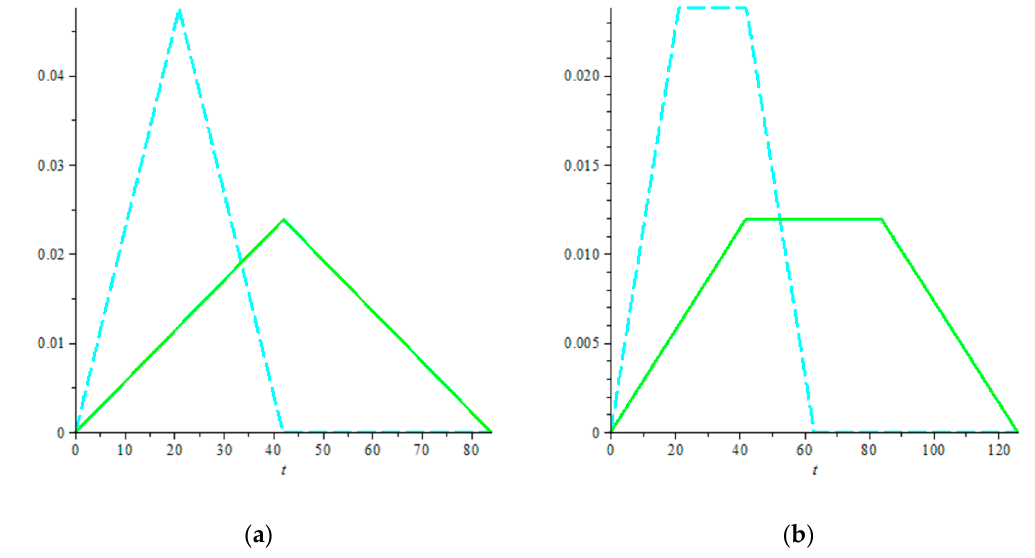
Figure 9. PDFs for the travel times of a semi-random trip (cyan dash) and an SC cycle (green solid) in a taxicab geometry: ( a ) in a square-in-time zone with T x = T y = 21 s ; ( b ) in a zone with T x = 2 T y = 42 s .